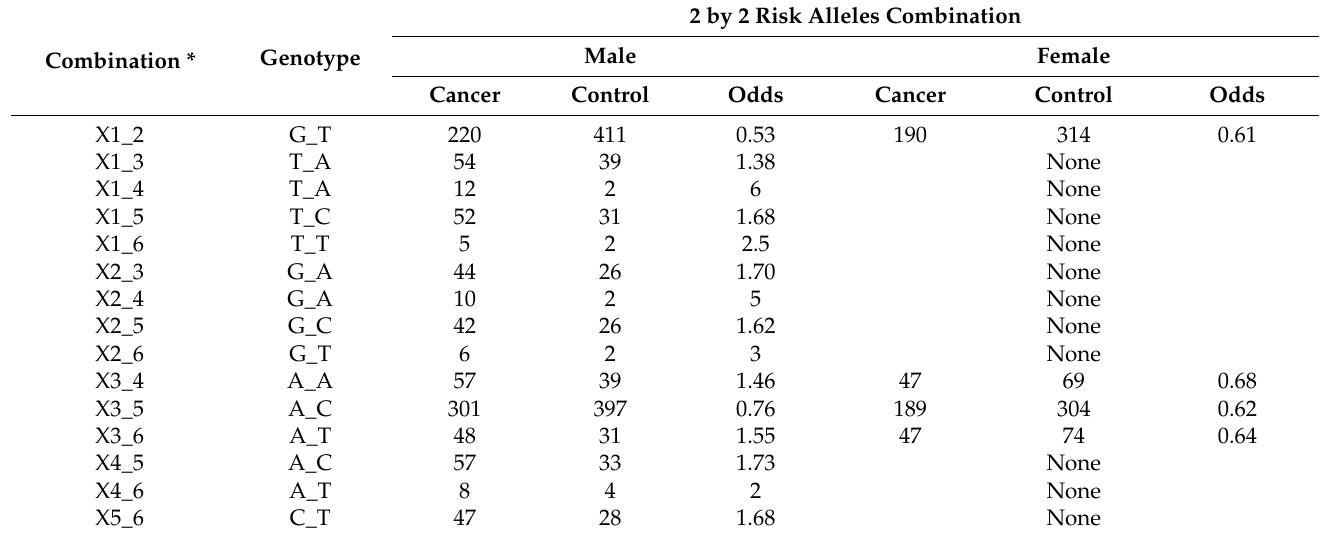
Table 5. Risk alleles pairwise combination analysis.